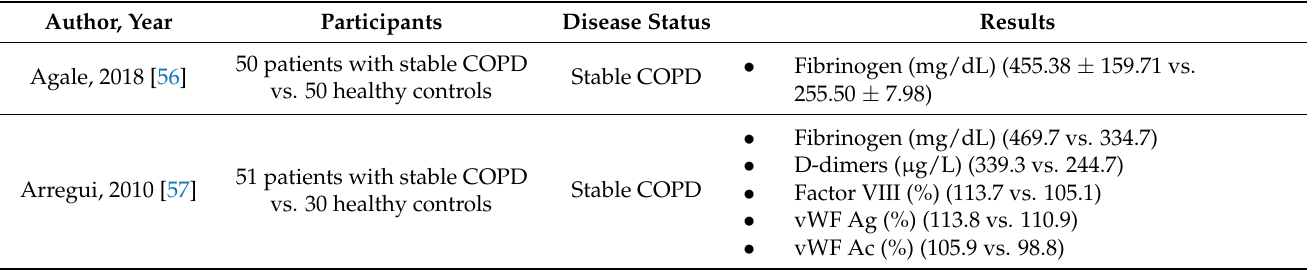
Table 1. Alterations of coagulation factors and inhibitors in patients with stable COPD and during COPD exacerbations. Author,